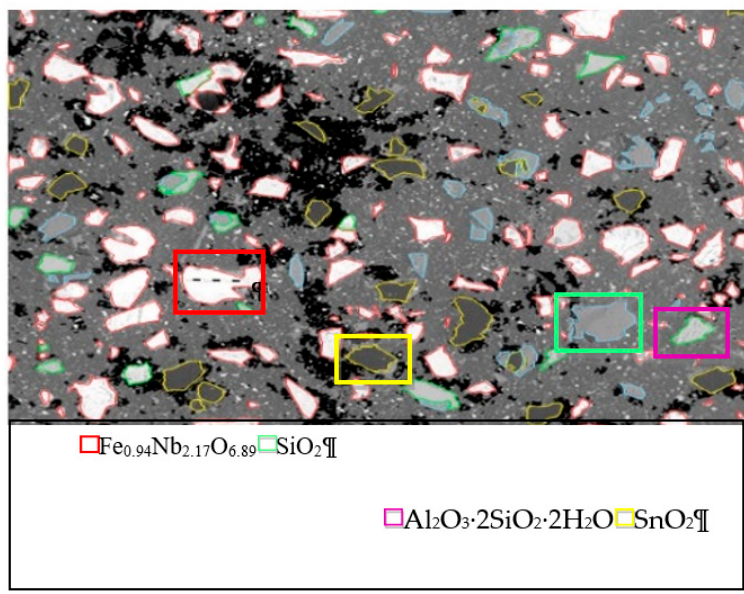
Figure 3. Different mineral phases in columbite–(Fe).